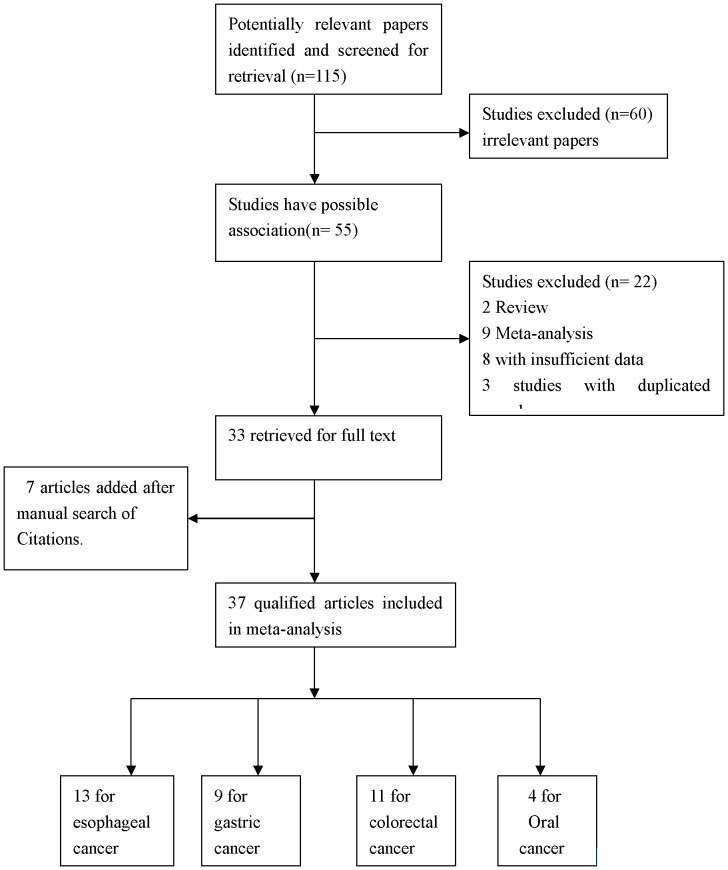
Flow diagram of studies identification.